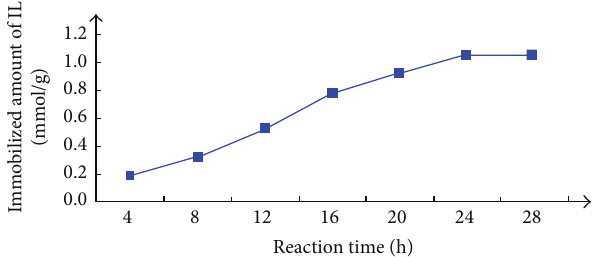
Figure 3: The relationship of immobilized amount and reaction time.